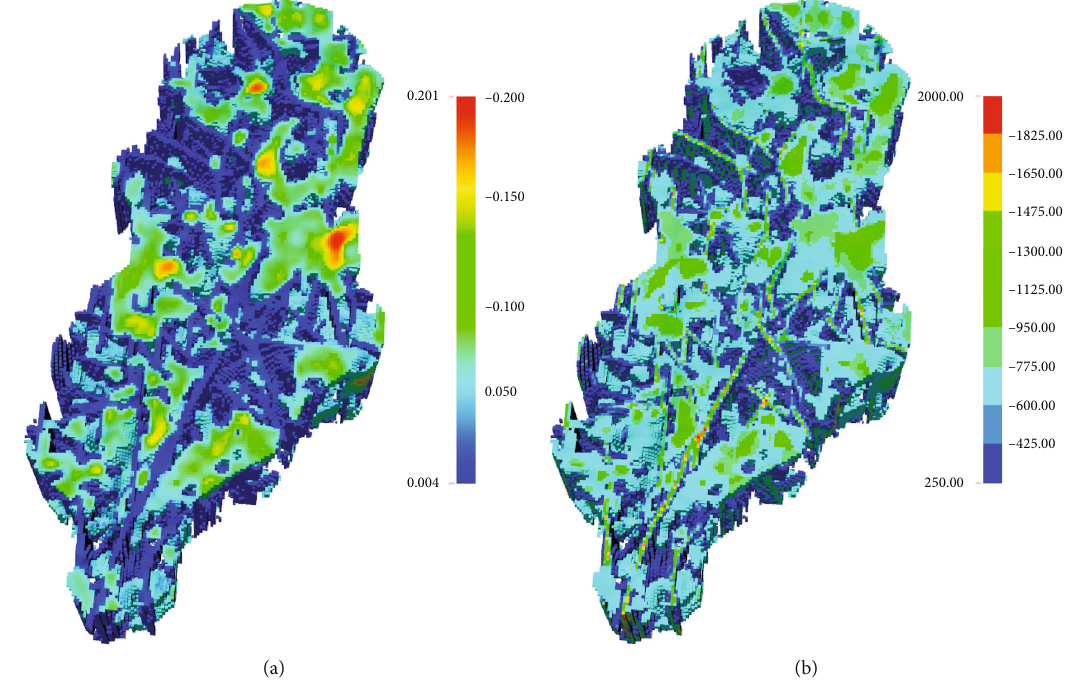
Figure 2: Porosity and permeability fi elds of L11 unit. Table 1: Physical parameters of the numerical simulation model of the L11